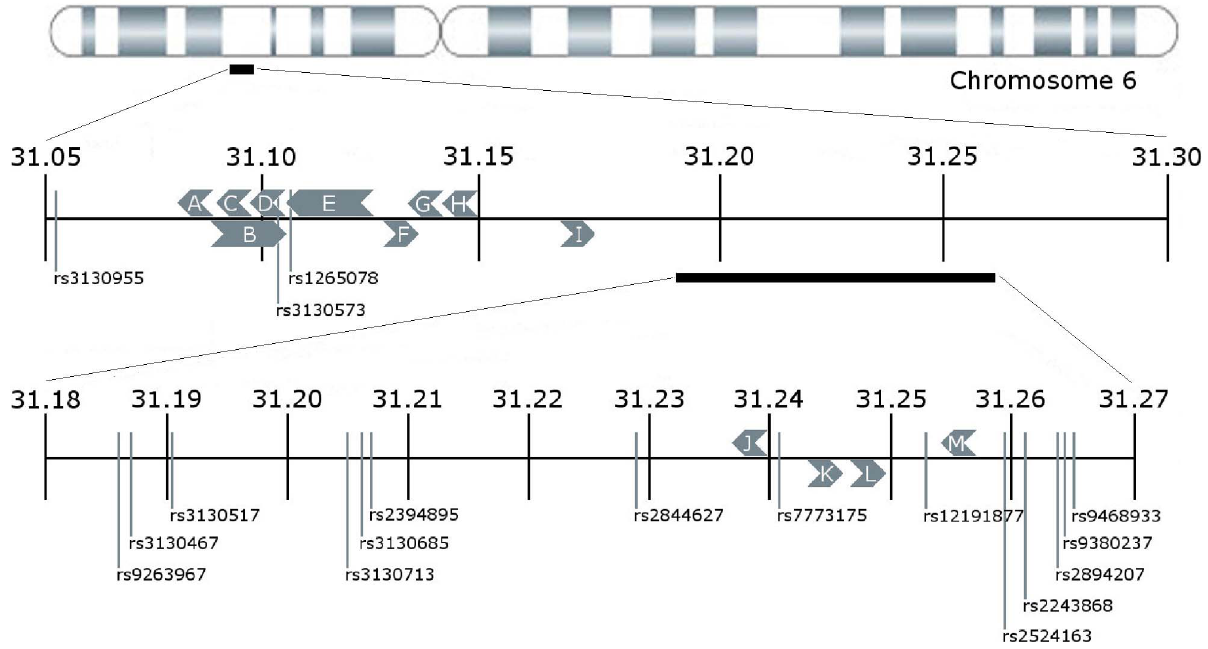
Figure 5. Map of the ps_1 bloc on chromosome 6. Genes are represented by: (A) C6orf15 , (B) PSORS1C1 , (C) CDSN , (D) PSORS1C2 , (E) CCHCR1 , (F) TCF19 , (G) POU5F1 , (H) PSORS1C3 , (I) HCG27 , (J) HLA_C , (K) USP8P1 , (L) RPL3P2 , and (M) WASF5P . Two SNPs are within known genes: rs3130573 in PSORS1C1 and PSORS1C2 , and rs1265078 in CCHCR1 . Shown are chromosomal positions (in Mb) according to Genome Build 37.3, as given by NCBI’s dbSNP website